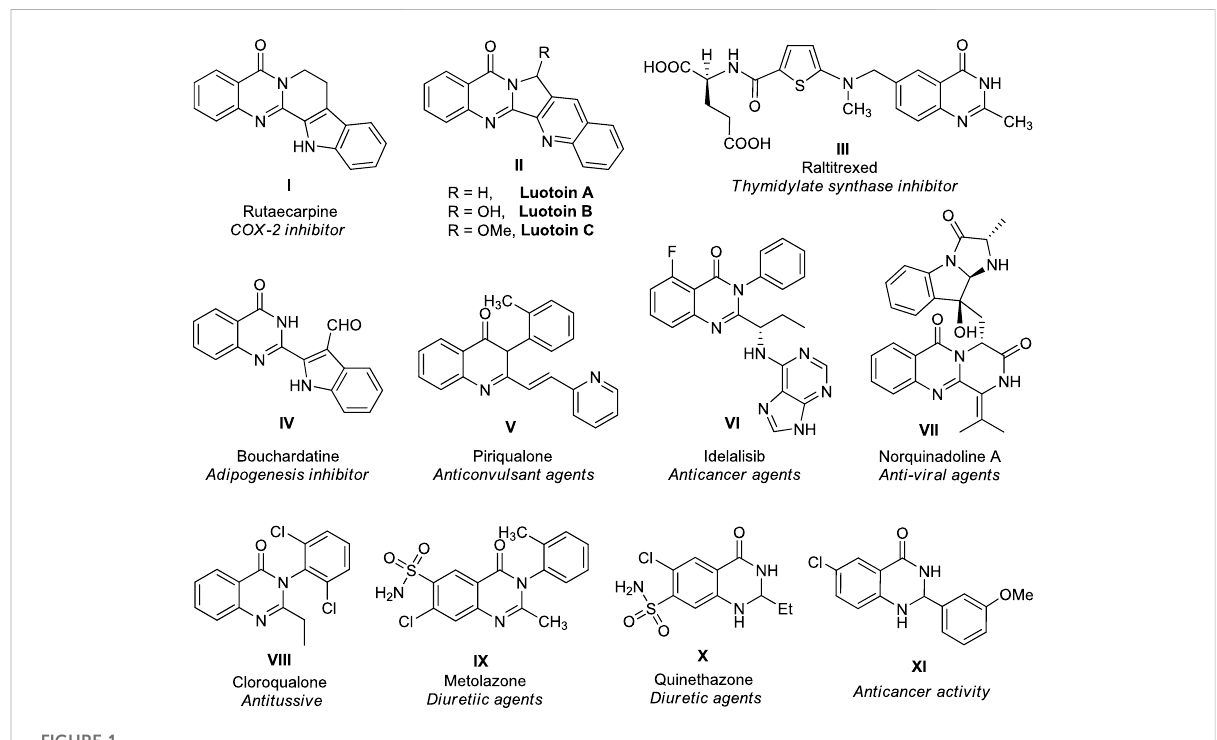
FIGURE 1 Representative examples of natural products and therapeutically potential